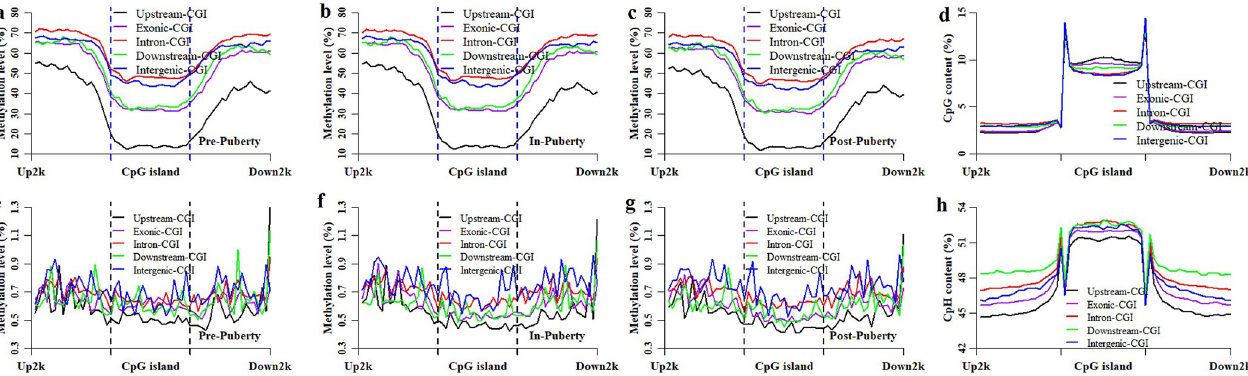
Fig 5. Methylation patterns of differently genomic CGIs. The CpG methylation patterns of Upstream-, Exonic-, Intronic-, Downstream-, and Intergenic- CGIs in Pre- ( a ), In- ( d ) and Post- ( c ). The CpG ( d ) and CpH ( h ) densities patterns of Upstream-, Exonic-, Intronic-, Downstream-, and Intergenic-CGIs in the porcine genome. The CpH methylation patterns of Upstream-, Exonic-, Intronic-, Downstream-, and Intergenic-CGIs in Pre- ( e ), In- ( f ) and Post-pubertal stage ( g ).